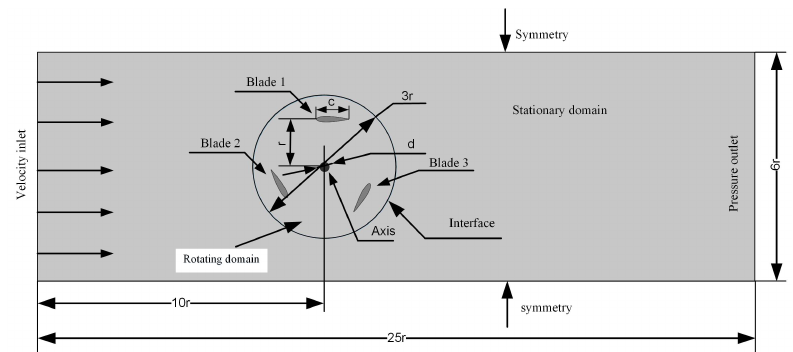
Figure 7. Two-dimensional computational domain model.